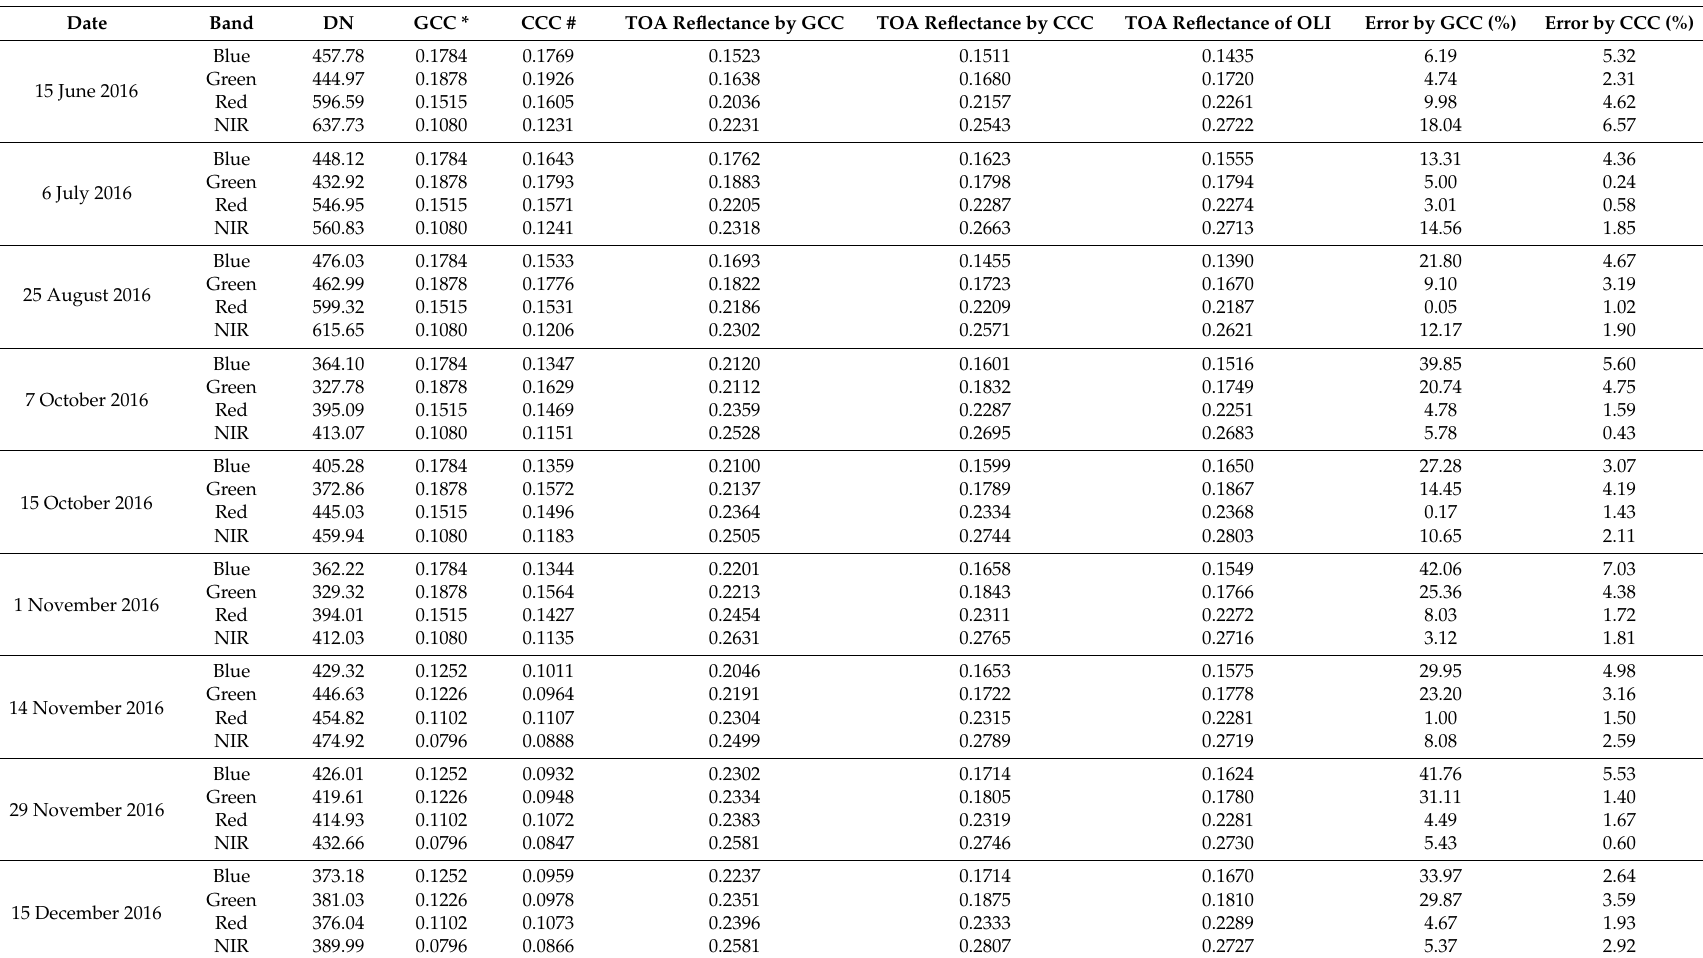
Table 11. GF-4/PMS cross-calibration validation